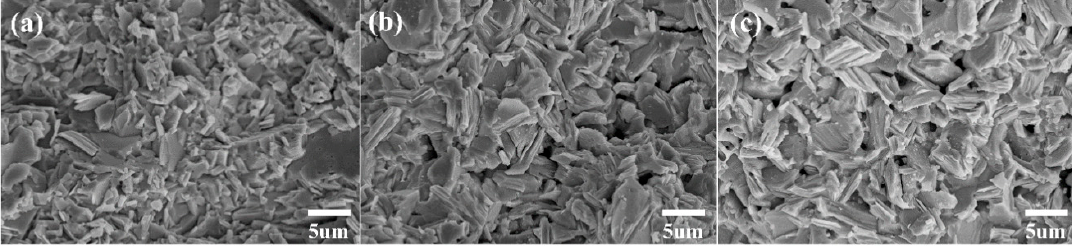
Figure 2. Field emission scanning electron microscope (FE-SEM) micrographs taken from the fracture surface of the polycrystalline ( a ) SnSe, ( b ) SnSe 0.9 Te 0.1 , and ( c ) SnSe 0.7 Te 0.3 . The surfaces of the samples were not polished.